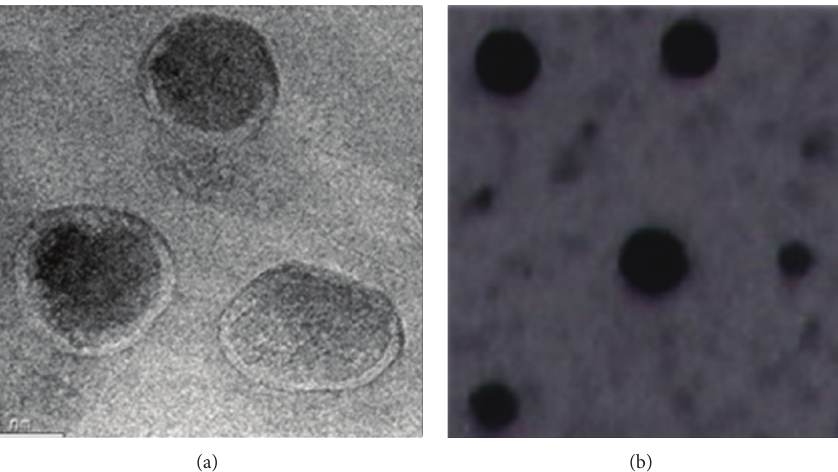
Figure 1: Transmission electron microscopy. Images of nanoparticles with the size of 100–150nm. (a) Nanoparticles formed by chitosan/plasmid with the size of 100–150nm (CS-NP). (b) Nanoparticles formed by chitosan/plasmid/magnetic nanoparticle with the size of 200–250 nm (CS-MNP).